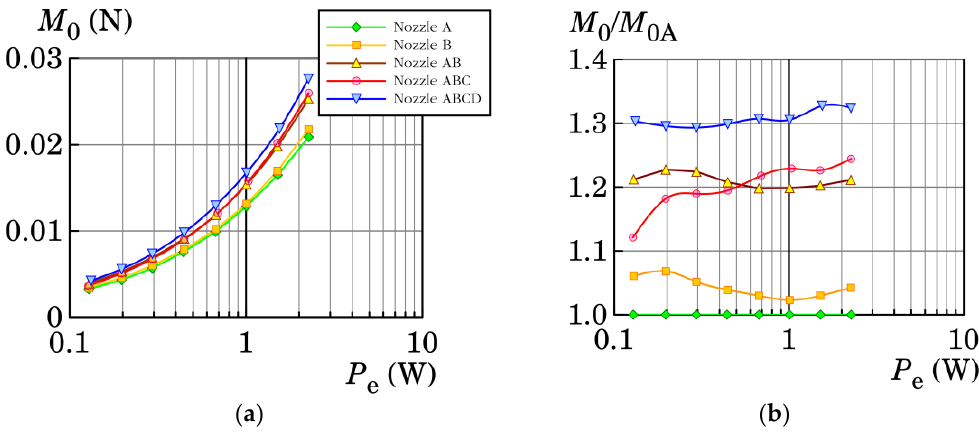
Figure 3. Results for experiments with precision scales performed at eight input power levels: ( a ) evaluated SJ thrust, ( b ) SJ thrust divided by the jet thrust values of the reference case—nozzle A.